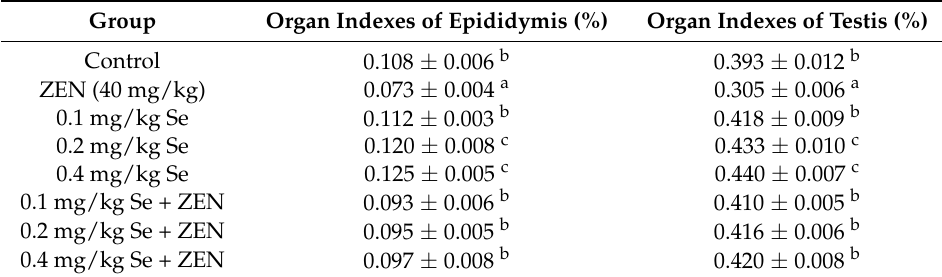
Table 1. Effect of Se on organ indexes of epididymis and testis in mice induced by ZEN. Group Organ Indexes of Epididymis (%)